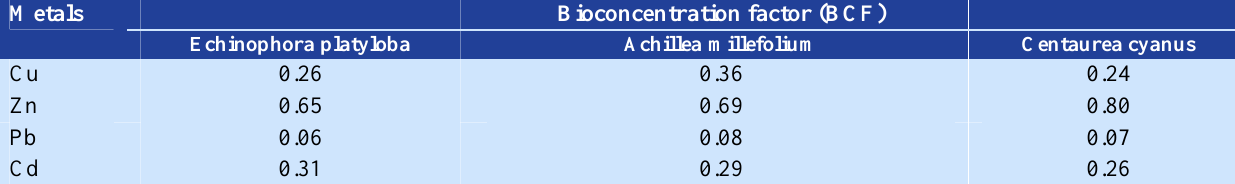
Table 7. Accumulation of Cu, Zn, Pb and Cd in the selected medical